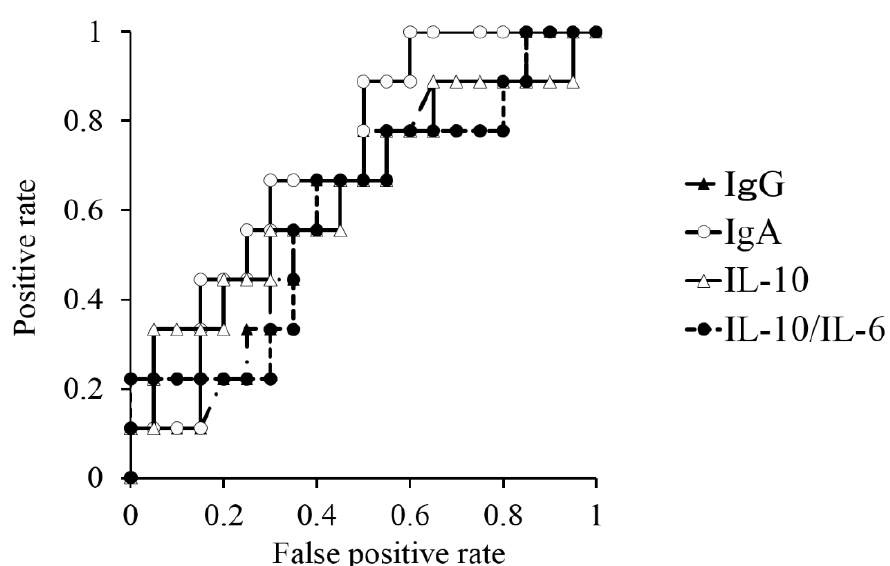
Figure 2. Receiver operating characteristic (ROC) curves for serum IgG, serum IgA, vitreous IL-10 and vitreous IL-10 / IL-6 ratio. The area under the curve (AUC) of IgA is the biggest among the four markers. Cutoff value of IgA is 184 mg/dL, with the highest odds ratio. Table 6. Cutoff value obtained from the ROC curve.